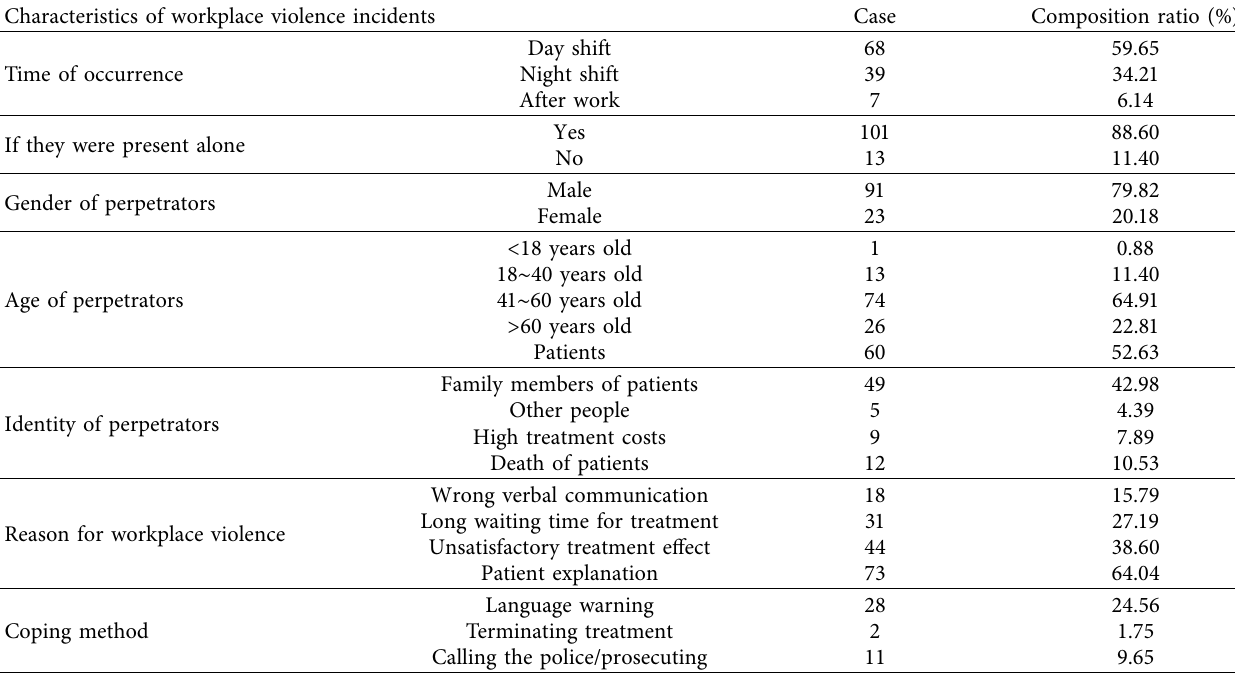
Table 2: Characteristics of workplace violence incidents suffered by ICU medical staff.